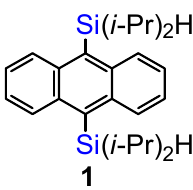
Figure 1. Structure of 1 .